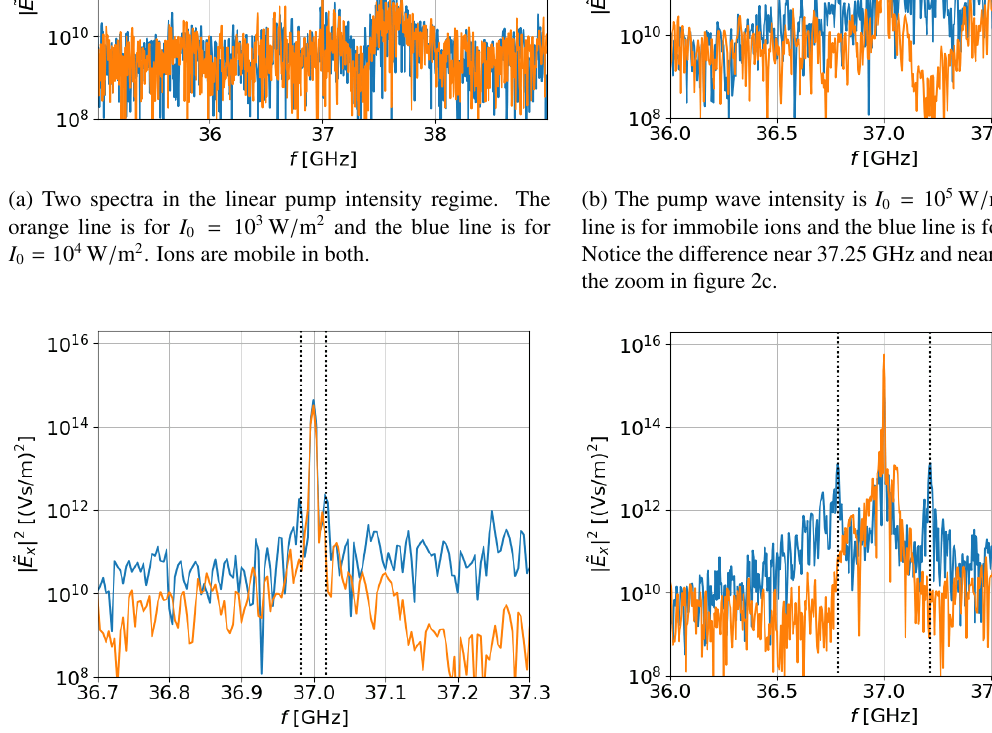
Figure 2: Frequency spectra of the longitudinal electric field spectrum near the ω 0 / (2 π ) = 37 GHz pump